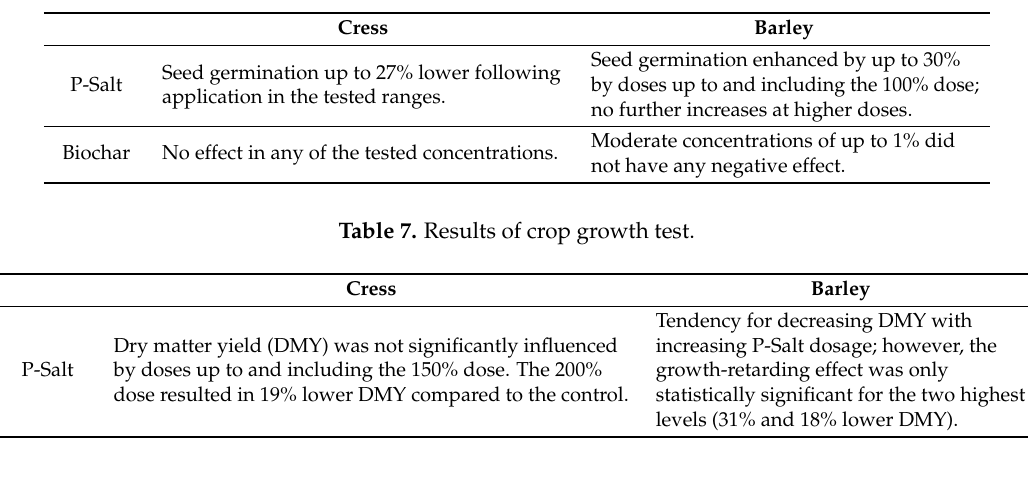
Table 6. Results of germination test.